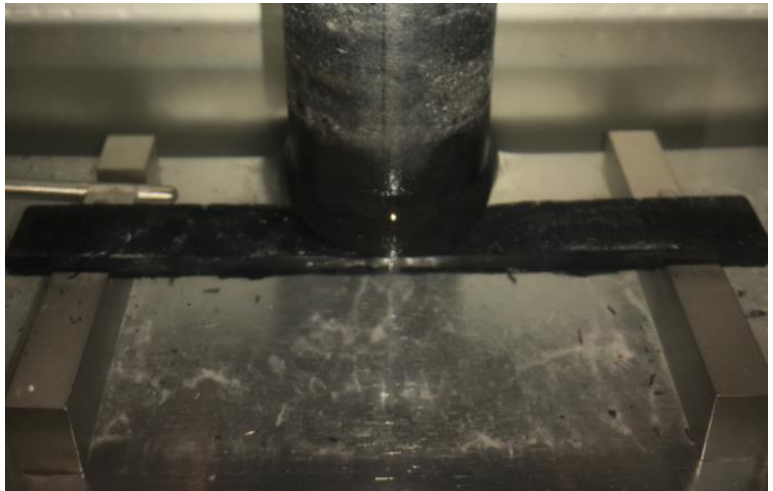
Figure 5. A sample of asphalt binder in the BBR test. creep rate m-value can be calculated based on the measured creep mechanical stress and strain data. The flexural creep stiffness S ( t ) is determined using Equation (3), where δ ( t ) is the deformation at the mid-span of the thin beam sample, P is the constant load, and h , L , and b are the thickness, length, and width of the thin beam sample. The flexural creep rate m ( t ) is the absolute value of the slope of the flexural creep stiffness S ( t ) versus time curve in the double logarithm coordinate system. In particular, creep compliance D shares a countdown relationship with flexural creep stiffness modulus S , which can be further applied to explore more rheological behaviors of asphalt binder via the BBR test.